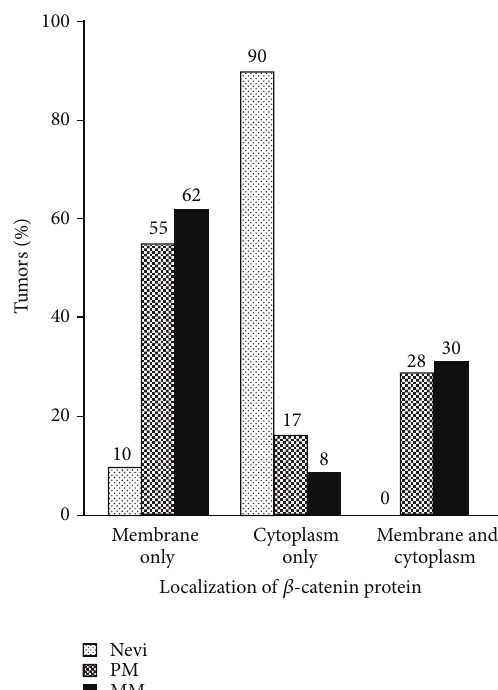
Figure 4: Subcellular localization of 𝛽 -catenin in nevi, primary melanomas (PM), and metastatic melanomas (MM). Percentages of tumors expressing 𝛽 -catenin exclusively in the cytoplasm or on cell membrane, or in both